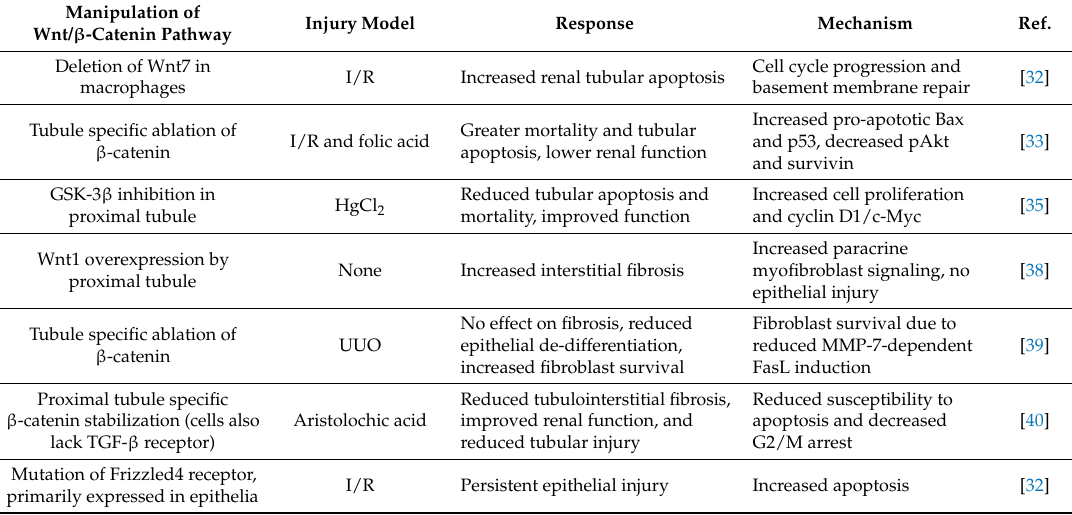
Table 1. Genetic manipulation of Wnt/ β -catenin signaling and its effects (direct and indirect) on renal tubular epithelia. Studies that have genetically altered the Wnt/ β -catenin signaling pathway either directly in renal tubules or indirectly (with effects on renal tubules) are listed with the injury models used, response of the conditional knockout or transgenic mouse, putative mechanism, and the appropriate reference. Of note, while the response noted is in vivo, the mechanism may be based on in vitro experiments. Studies manipulating Wnt/ β -catenin signaling in the glomerular epithelial cells (podocyte, parietal epithelium) were beyond the scope of this review. Several additional studies have looked at Wnt/ β -catenin in the injured kidney using systemic inhibitors, but these were not included, as they do